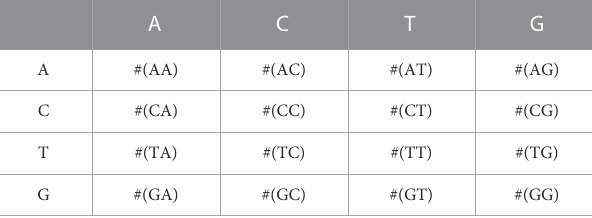
TABLE 3 Co-occurrence matrix I that contains several patterns of A , C , T , G nucleobases in DNA gene sequence S